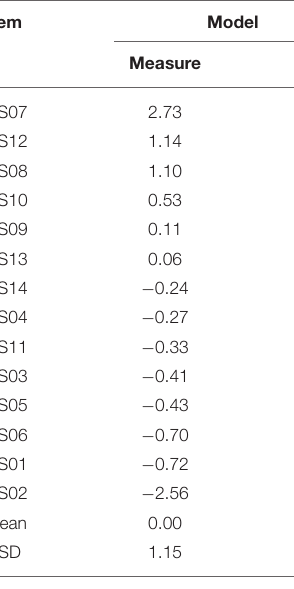
Figure 2 located both items (difficulty levels) and persons (distribution of person ability) on the same continuum of fundamental movement skill. The figure indicated that the subjects’ fundamental movement skill levels ranged from − 1.58 to 4.51 logits, and the range of item response difficulty ( −